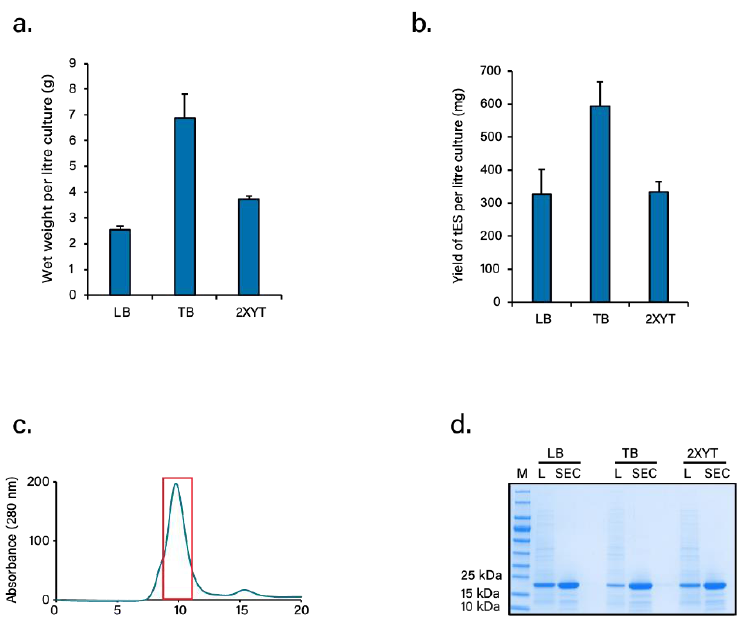
Figure 1. Expression of tES. ( a ) Comparison of wet weight of bacterial cell mass produced in LB, TB, and 2XYT media. ( b ) Comparison of overall yields of tES expressed in LB, TB, and 2XYT media. ( c ) Purification of tES by size-exclusion chromatography (SEC). (Note: Fractions of the tES peak (rectangle box) were analyzed for purity in SDS-PAGE, pooled, and concentrated for various experiments). ( d ) SDS-PAGE analysis of purified tES compared to lysate (L).